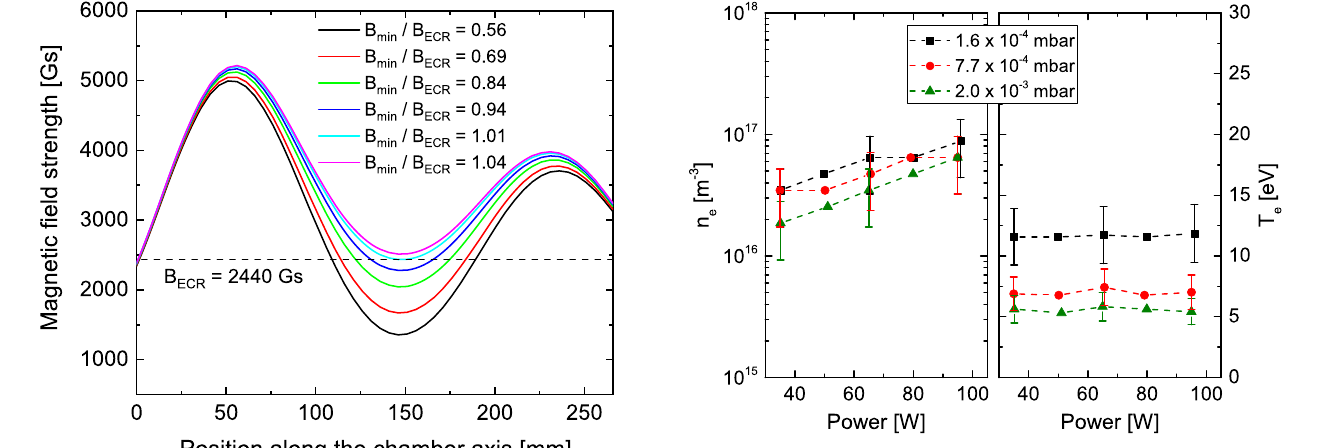
=B ratio. min ECR